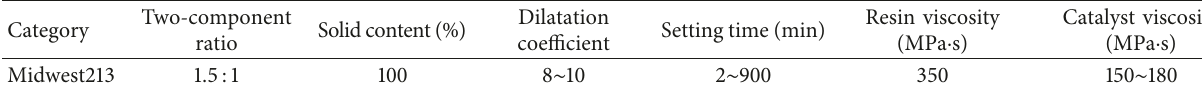
Table 5: Main technical parameters of water plugging chemical grouting.